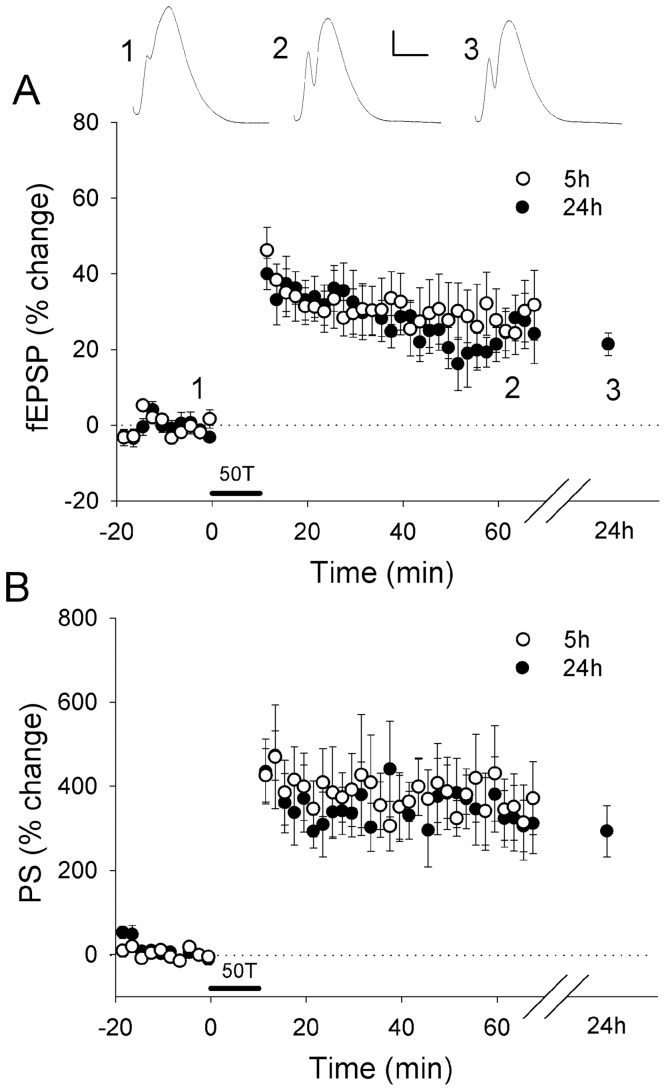
Induction of robust LTP by 50×400
Hz, 10 impulse trains (HFS) at perforant path dentate granule cell synapses. Data are mean ± standard error (n = 5) for the fEPSP (A) and population spike (B). Inset waveforms are averages of 10 sweeps (5 min) for one animal, taken during baseline (1), 45–60 min (2) and 24 h (3) after HFS. Calibration bars: 5 ms, 5 mV.